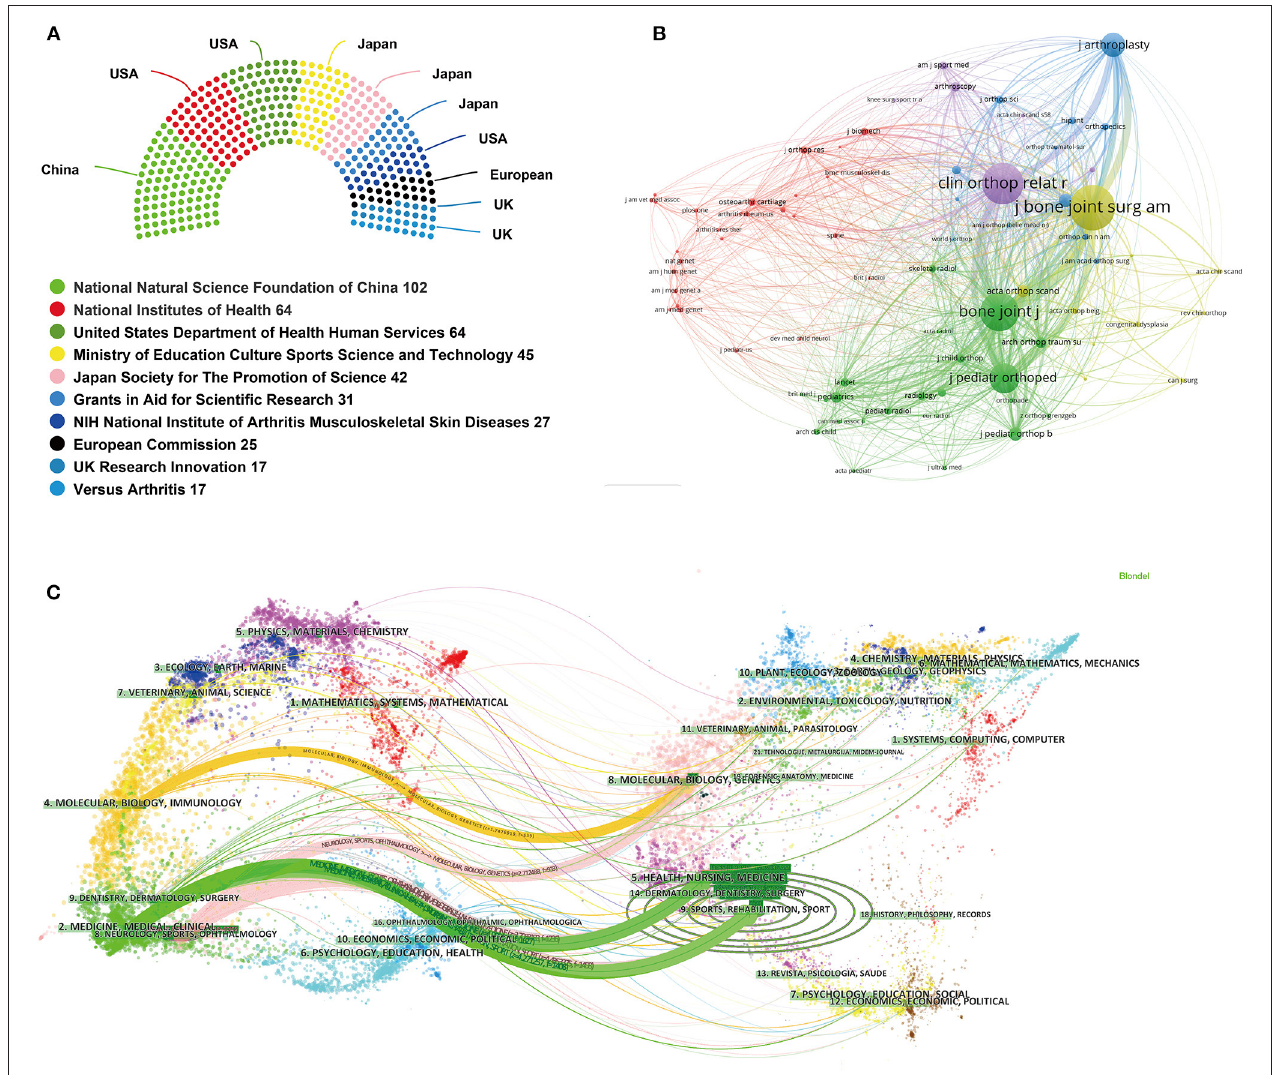
FIGURE 6 | (A) Top 10 related funding agencies for the support of DDH research. (B) Journal co-citation analysis by using VOSviewer. Each node represents a different journal, and the node size is proportionate to the number of citations. (C) A dual-map overlay of the journals on DDH research by using CiteSpace. three of them were from the USA, three from Japan, two from the UK, and one each from European Union and